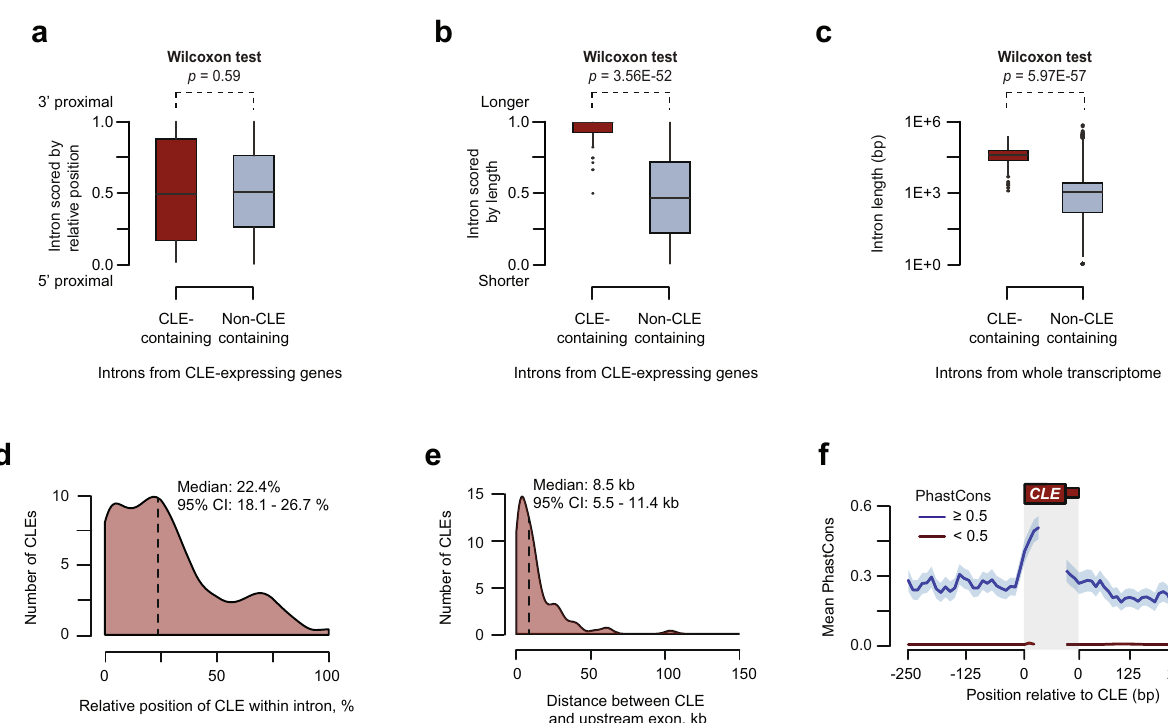
Fig. 3 Molecular properties of CLEs. a , b CLE containing ( n = 109) and non-CLE ( n = 1557) containing introns from CLE-expressing genes were scored by their relative position ( a ) and relative length ( b ), and the distributions of these scores were plotted. Note that CLE-containing introns show no gene position bias but tend to be among the longest introns in the gene. The box bounds represent the fi rst and third quartiles and the black lines at the middle of the boxes show the medians. Top and/or bottom whiskers represent 1.5x of the range between the third and the fi rst quartiles (interquartile range). Circles represent outliers. Two-sided Wilcoxon rank sum test was performed. c CLE-containing introns ( n = 109) are longer compared to all other introns in the zebra fi sh transcriptome ( n = 209,012). The box bounds represent the fi rst and third quartiles and the black lines at the middle of the boxes show the medians. Top and/or bottom whiskers represent 1.5x of the range between the third and the fi rst quartiles (interquartile range). Circles represent outliers. Two-sided Wilcoxon rank-sum test was performed. d CLEs tend to occur relatively close to the 5 ′ end of their host introns. e CLEs are found within 10 kb of the upstream constituitive exon. f Metaplot showing the conservation score of sequences surrounding conserved (blue) and non-conserved (red) CLEs. In all, 280 bp of surrounding intron/CLE junction sequence (250 bp intron and 30 bp exon) were binned into 10 bp windows and the mean PhastCons score for each bin is shown